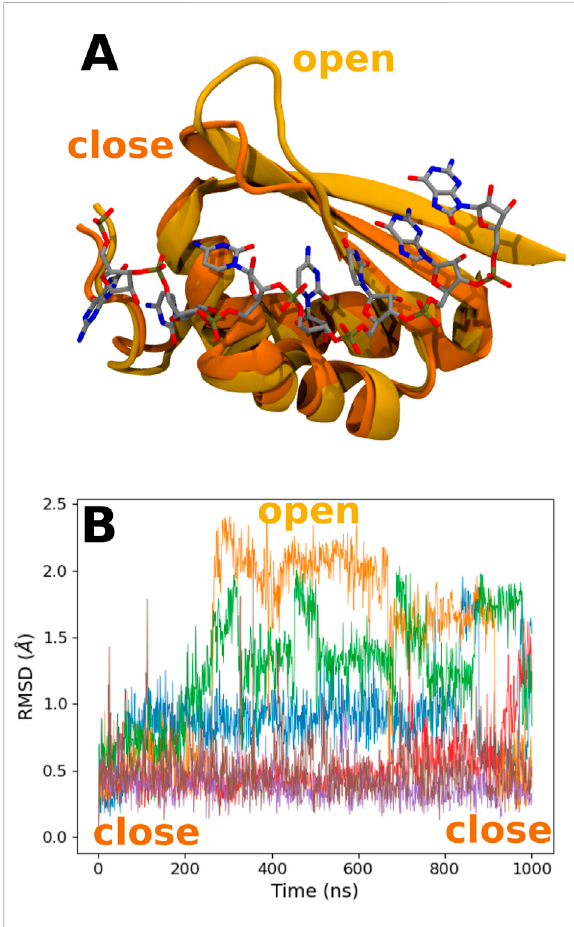
FIGURE 6 (A) Representation of the close and open conformations of the 49 – 55 PCBP1 loop in the presence of the ° GCCCUG ° G sequence. (B) RMSDoftheC α atomsofthe49 – 55PCBP1 residues in the presence of the six studied RNA sequences: control (blue), ° GCCCUG ° G (orange), GCCCU ° GG (green), ° GCCCUGG (red), GCCCUG ° G (violet), and ° GCCC ° GGG